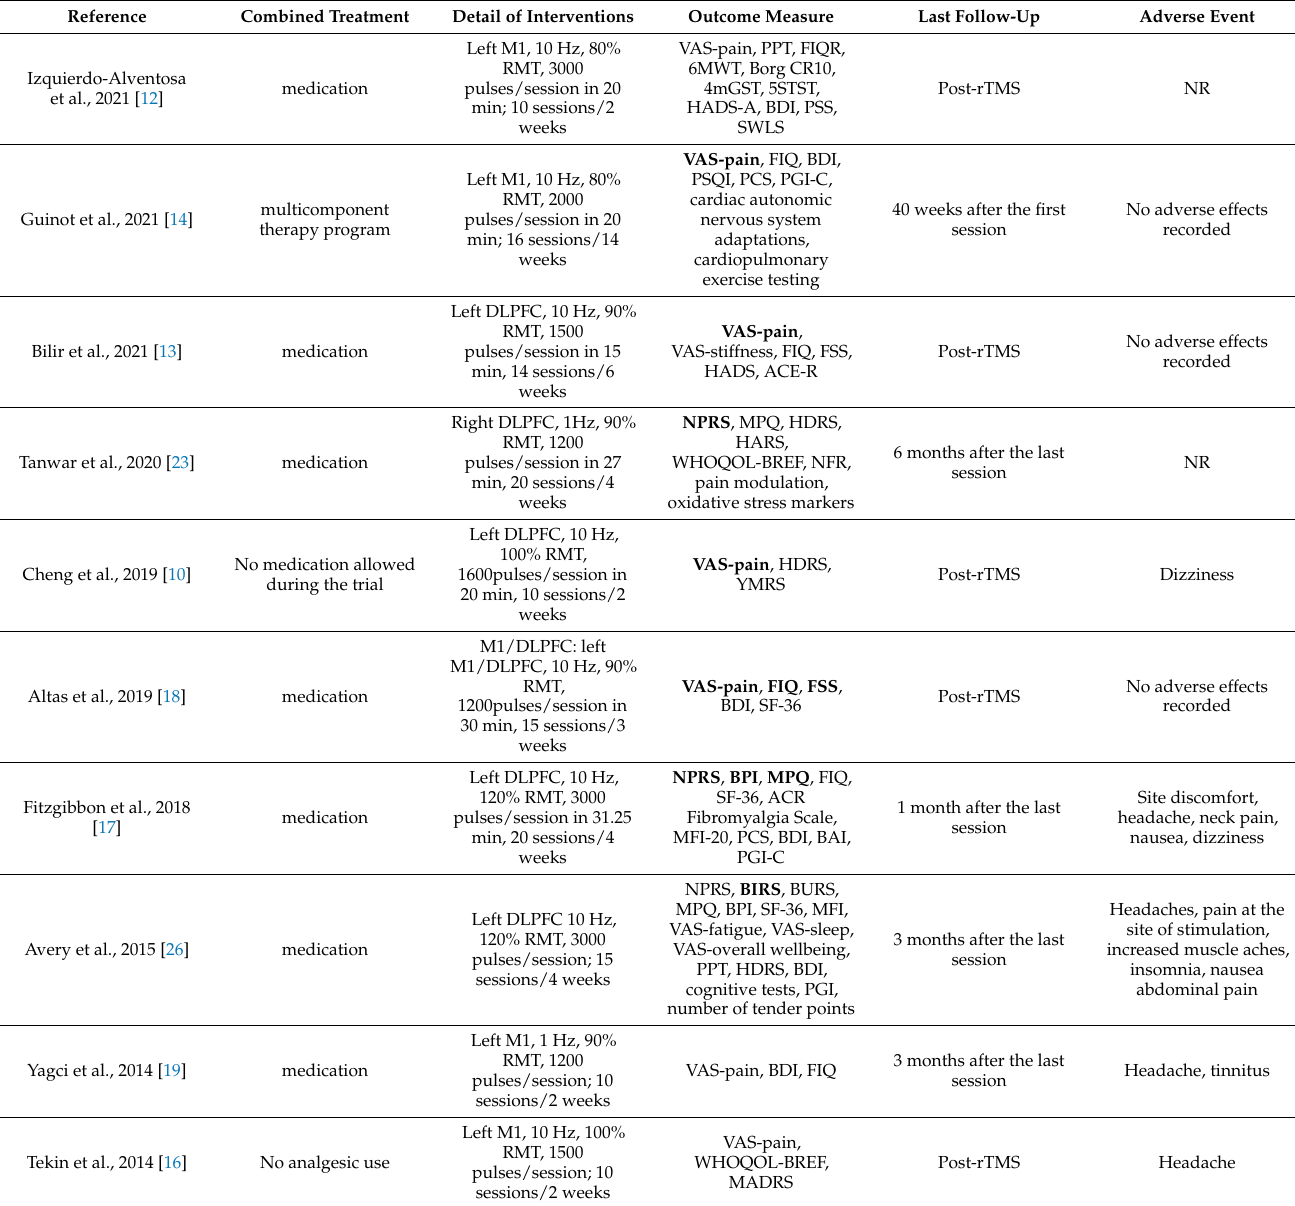
Table 2. Summary of extracted data from the included